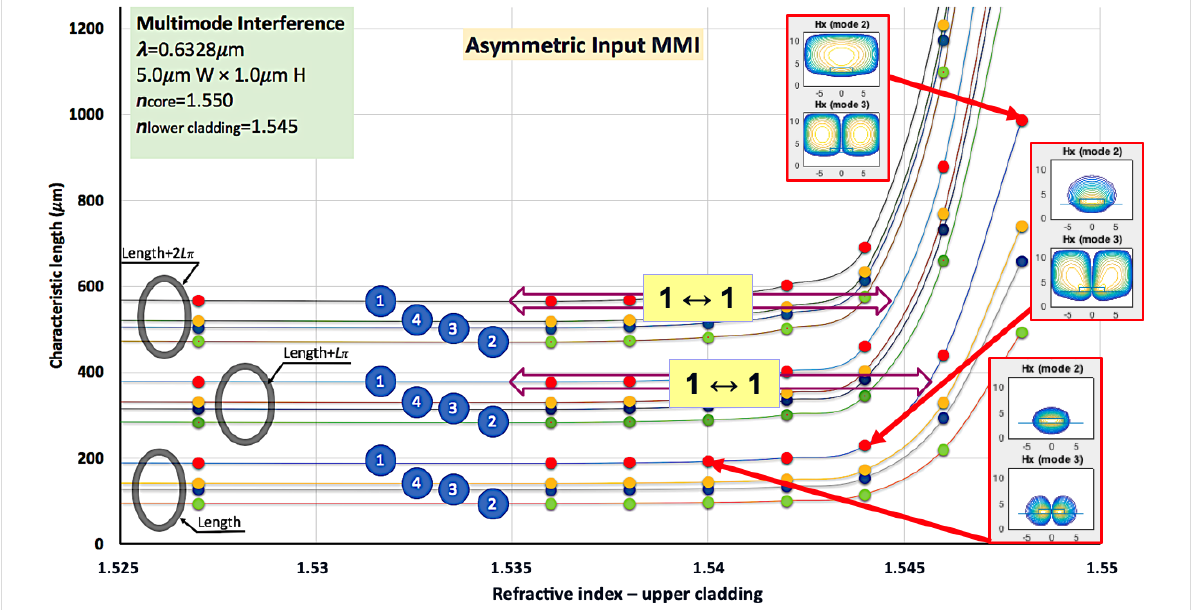
Figure 5: The characteristic length of an MMI is nearly constant until the cladding index reaches values close to the core index. Optical switches can be obtained in this region, as shown by the 1 ↔ 1 double arrows. However, modes become leaky when the cladding index values become too close to that of the core, as seen in the far-right